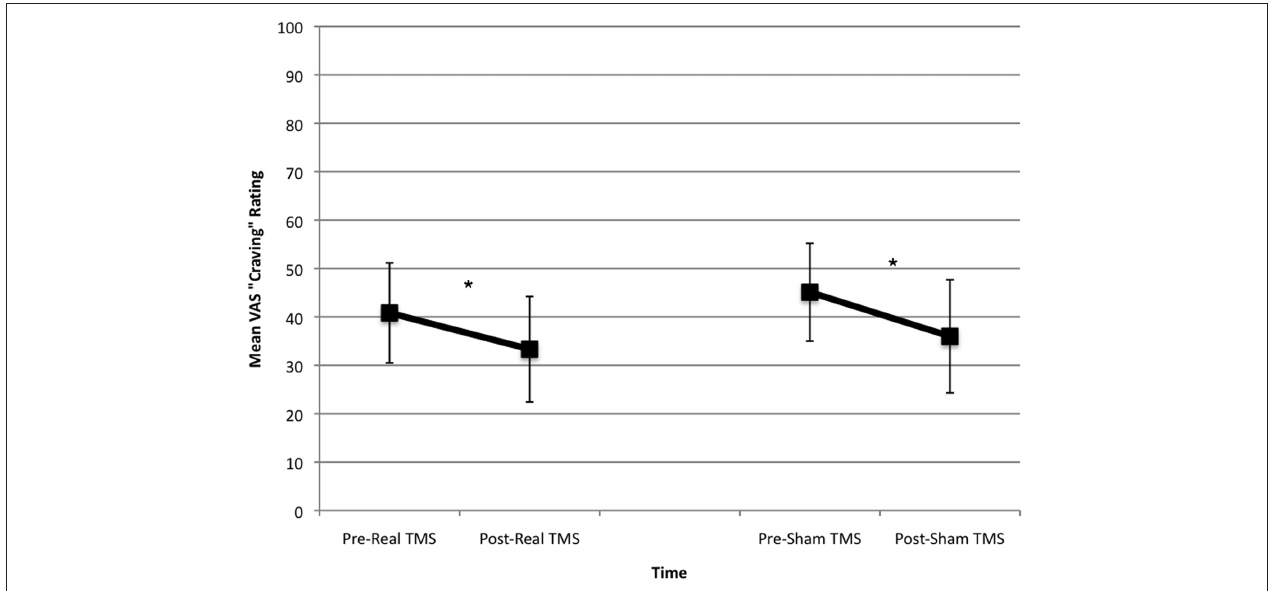
FIgure 1 | Changes in cravings ratings in real and sham-TMS conditions. There was a significant drop in cravings in both the real- and sham-TMS conditions, with no difference between conditions before or after controlling for hours since last